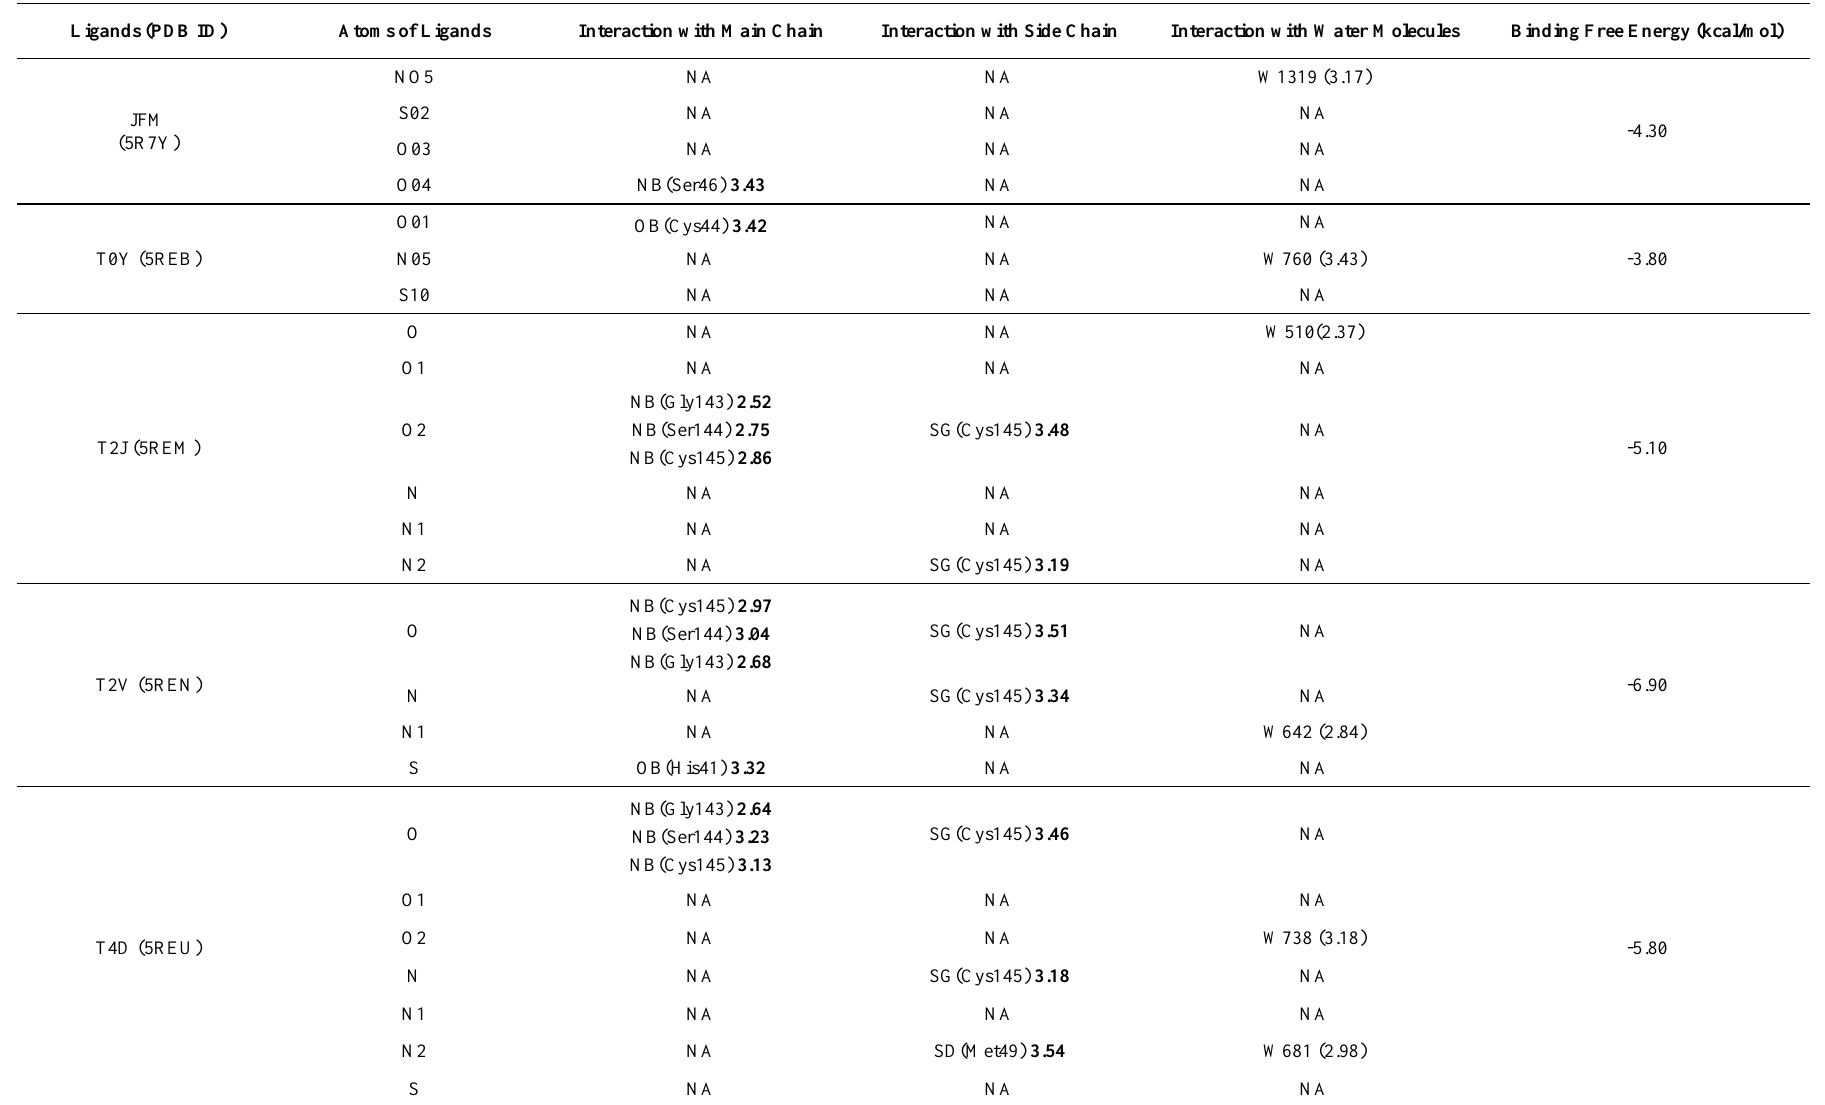
Table S2. H-Bond interactions from ligands to different residues in main protease (Mpro) crystal structures. The distances are within